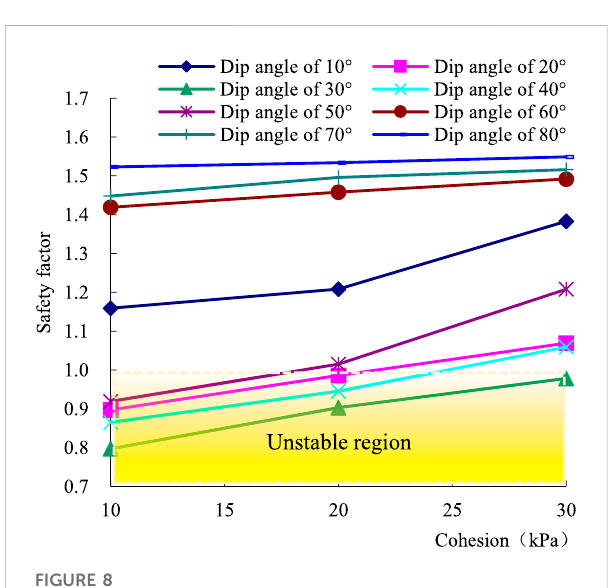
FIGURE 7 In fl uence of interlayer angle on safety factor at different interlayer cohesive.